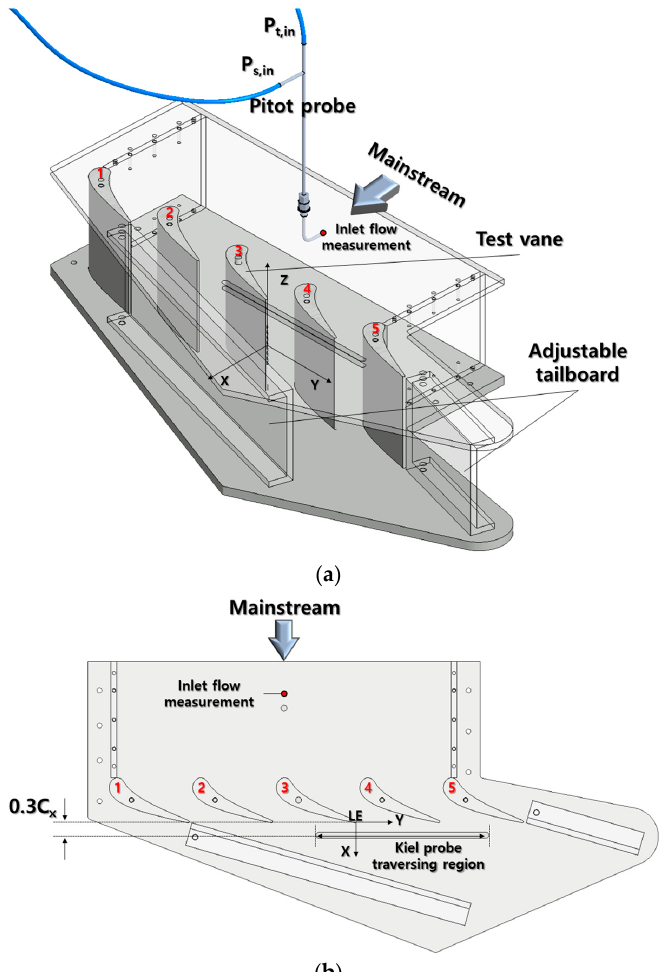
Figure 3. Experimental setup for the total pressure loss measurement: ( a ) 3D view; ( b ) top view. The total pressure loss measurement was performed at 20 m/s of the mainstream ve- locity measured using a Pitot probe at the cascade inlet. The inlet flow Reynolds number based on the axial chord length and the mainstream velocity was about 1.64 × 10 5 . The mainstream boundary layer thickness and the turbulence intensity measured using a hot- wire anemometer at the same location of the Pitot probe were about 8 mm and 1.1%, re- spectively. At the cascade outlet, a pair of adjustable tailboards was installed to allow the peri- odic flow of the cascade. In order to confirm the periodicity of the mainstream, the total pressure loss defined in Equation (3) was measured using a 2-axis traverse system with a Kiel probe (KBC-12, United Sensor Corp.) at the midspan height (Z/H = 0) and 0.3 axial chord length downstream from the trailing edge. In Equation (3), subscriptions t and s refer to the total pressure and the static pressure, and in and out indicate the cascade inlet and the outlet, respectively. Figure 4 presents the total pressure loss distribution over 2 pitches of the cascade and shows a good periodic flow field. Cp (cid:2930) =